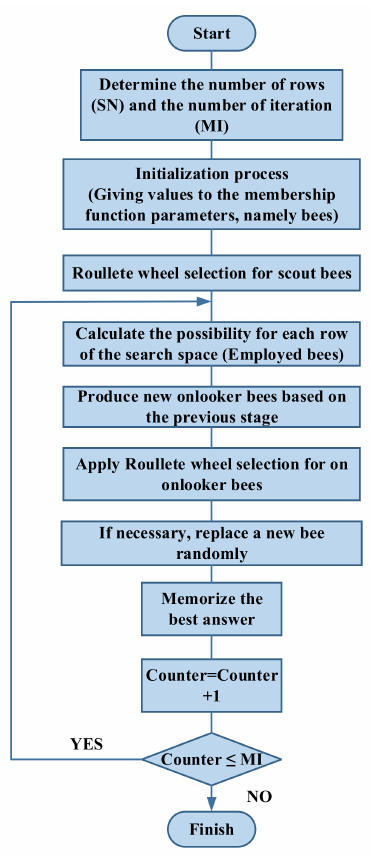
Figure 10. The flowchart of ABC